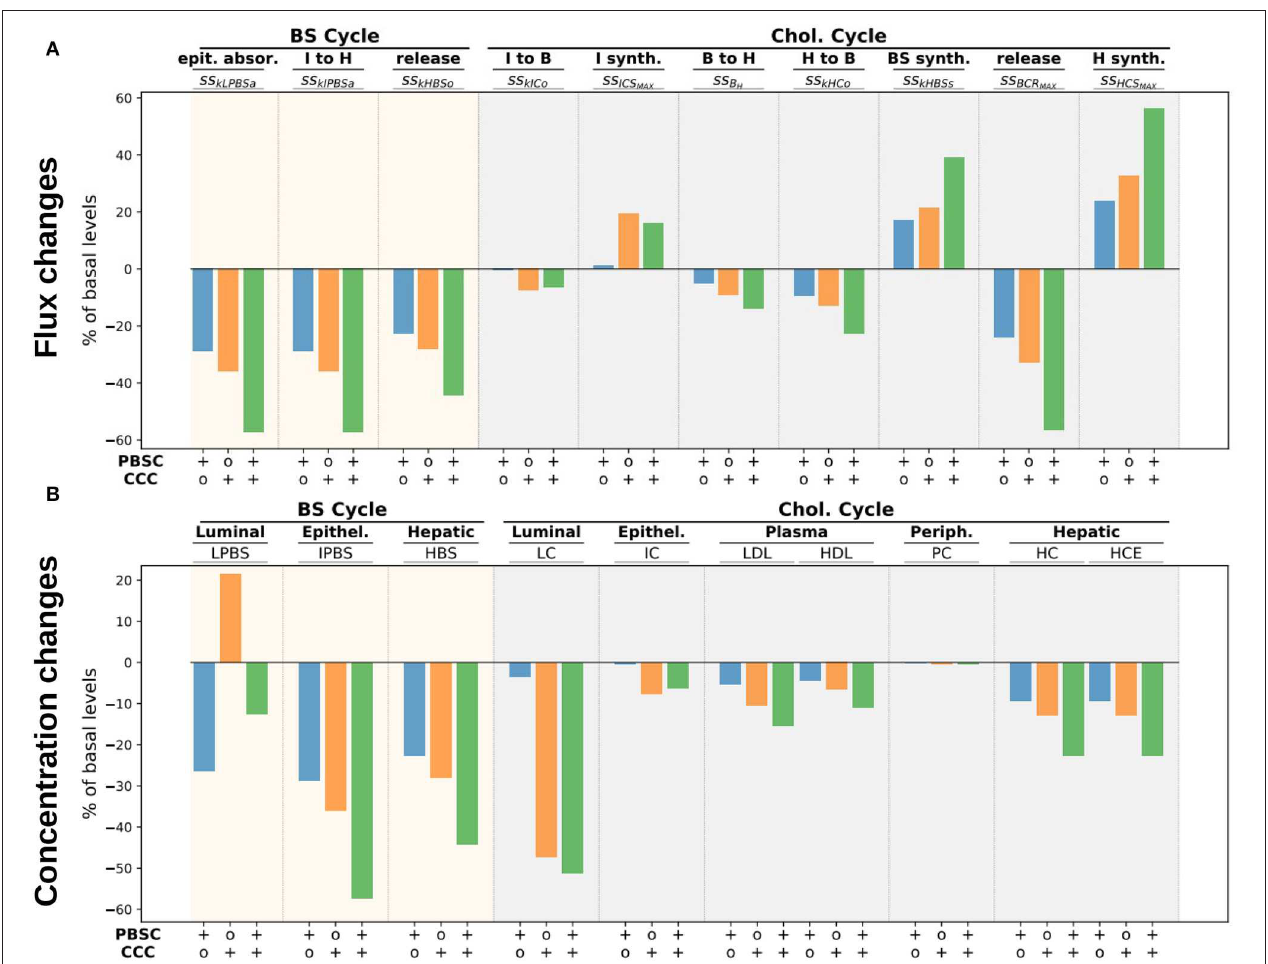
FIGURE 6 | Flux and concentration changes for higher bacterial activity. We display flux (A) and concentration (B) changes (in percentage of the basal respective quantities) for a 20-fold increase of PBSD (resp. CCC) levels in the lumen, i.e., BS (resp. cholesterol) bacterial converters. The steady state flux nomenclature can be found in Table S6 and Table 2